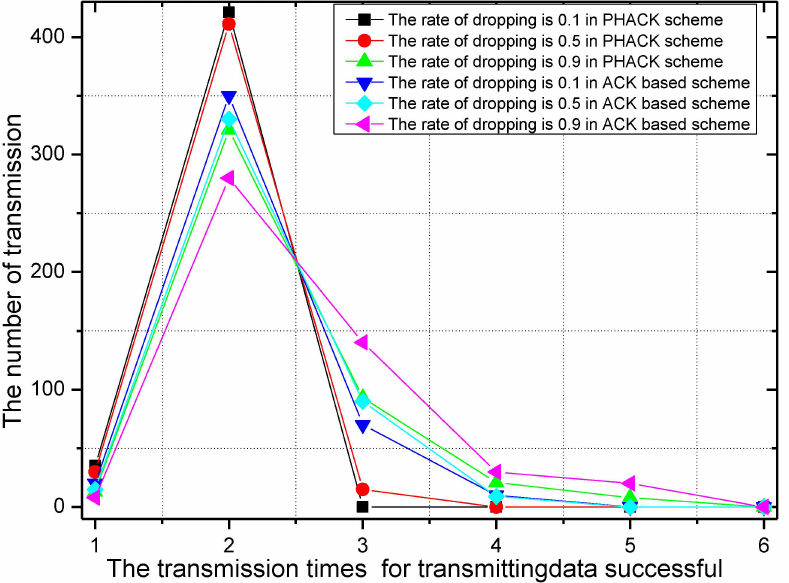
Figure 16. The number of successful data transmissions in the PHACK scheme with different rates for the dropping of data.